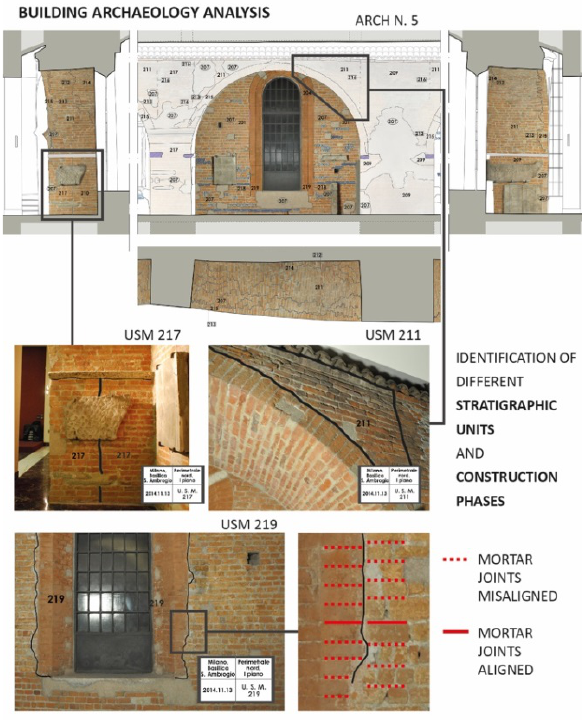
Figure 6. The generative SCAN-to-HBIM process based on GOG 9 and GOG 10. Thanks to new modeling requirements it has been possible to achieve high LOG and LOI.